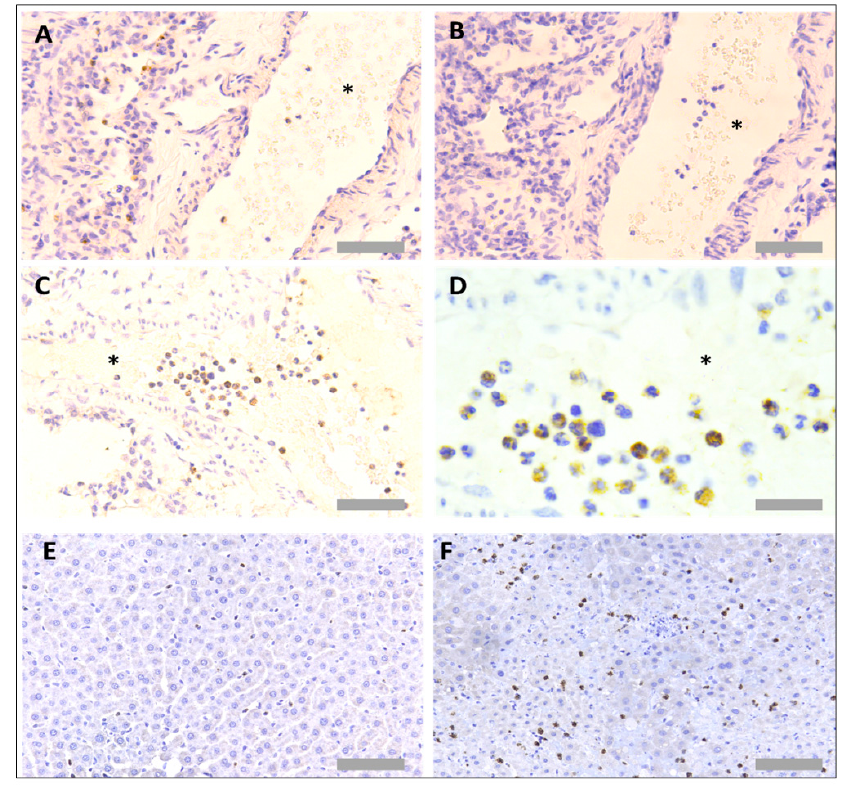
Figure 5. Neutrophil immunohistochemistry in pig lung and liver tissues. For protocol optimisa- tion, consecutive sections were immunostained with primary antibody ( A ) and without primary antibody ( B ), to ensure no unspecific binding of detection reagents. Representative images of neu- trophil immunohistochemistry (anti-MPO) in FFPE pig lung tissue ( C , D ) and FFPE pig liver tissue ( E , F ) are also shown. Asterisks denote blood vessels. Scale bar = 100 μ m in Figures ( A – C , E , F ) (×20 objective), 20 μ m in Figure ( D ) (×63 objective).